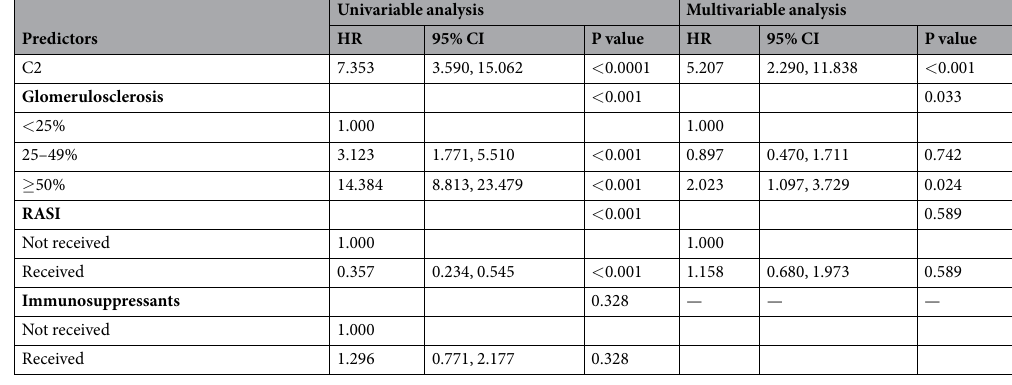
Table 2. Univariate and multivariable Cox proportional hazards regression analysis of the data from the development cohort. UPE, urinary protein excretion; eGFR, estimated glomerular filtration rate; RASI, renin- angiotensin system inhibitors.